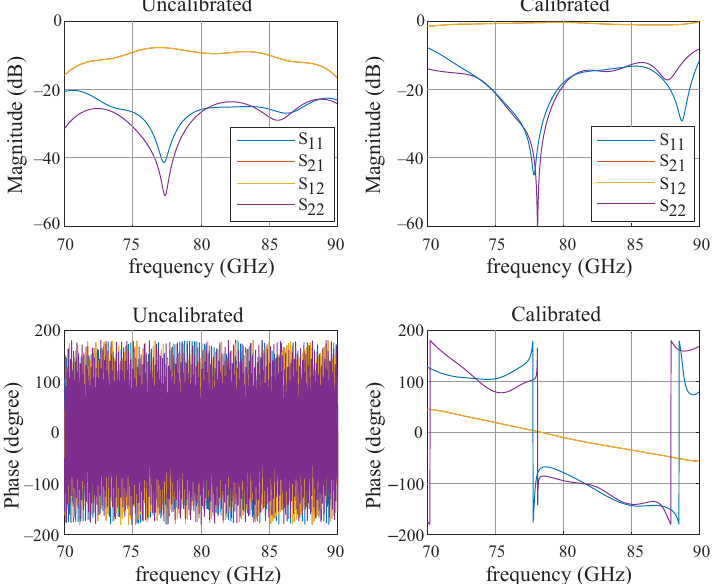
Figure 21. Time domain signals for a reflect standard ( a ), thru standard ( b ), line standard ( c ) and a MUT ( d ).